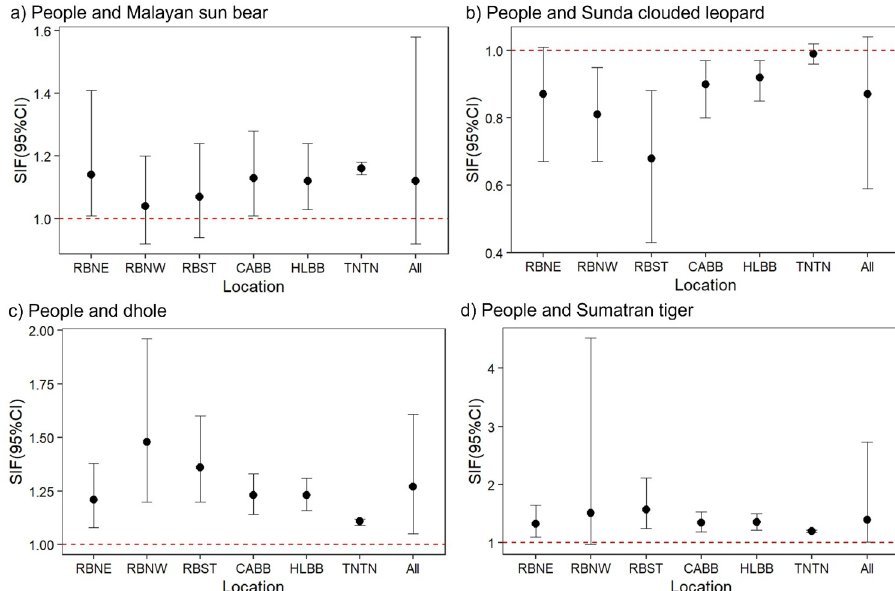
Fig 4. Spatial overlap between people (dominant, species A) and large carnivores (subordinate, species B) based on model-averaged Δ AIC c � 2 for 147 camera-trap stations across all study sites. A strong SIF is indicated by the 95% CI not overlapping with “1”; RBNE, Northeastern Bukit Rimbang Bukit Baling; RBNW, Northwestern Bukit Rimbang Bukit Baling; RBST, Southern Bukit Rimbang Bukit Baling; CABB, Bukit Bungkuk; HLBB, Bukit Betabuh; TNTN, Tesso Nilo; All, “All study sites”.